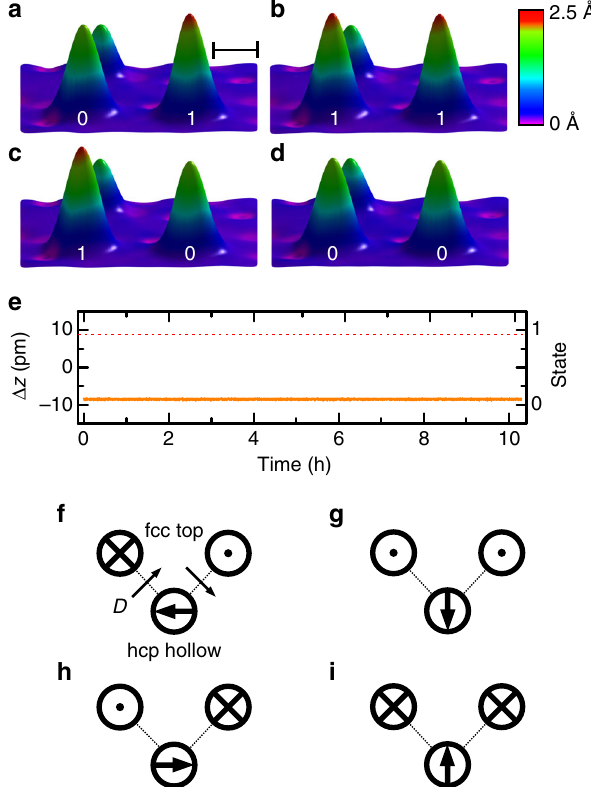
Fig. 5 Two-bit register and four-state memory based on giant moment clusters. a – d Spin-resolved constant-current images of two fcc top clusters in the four possible spin states (01), (11), (10), and (00), where 0 and 1 correspond to downwards and upwards pointing magnetization, respectively (imaging parameters: V = − 1 mV, I = 500 pA, B = 0 T, T = 0.3 K). The Fe atom in the back serves as a marker for the apparent height. The scale bar de fi nes a length of 1 nm. Between the images, the tip was positioned on top of the cluster whose state was intended to be changed, the bias was slowly increased until the state switched, and then quickly decreased to the imaging parameter. e The long-term stability of one of the two magnetic bits is shown by measuring the height of the cluster ( orange trace ) in the state 0 over more than 10 h ( V = − 0.7 mV, I = − 50 pA, B = 0 T, T = 0.3 K), without a single switch into the state 1, whose height reference is given by the red dotted line , which was determined from the magnetic contrast in images a – d . f – i , Top view schematic diagram of a possible memory with four different realized spin states on a hcp hollow cluster. The two upper circles in each panel illustrate two fcc top clusters prepared in magnetization states up ( dot ) or down ( cross ). The lower circle in each panel signi fi es a hcp hollow cluster (or a hcp atom), which is forced into one of the four spin states indicated by the thick arrow , as dictated by the Dzyaloshinskii – Moriya interaction D (orientation indicated by the two thin arrows ) to the two neighboring